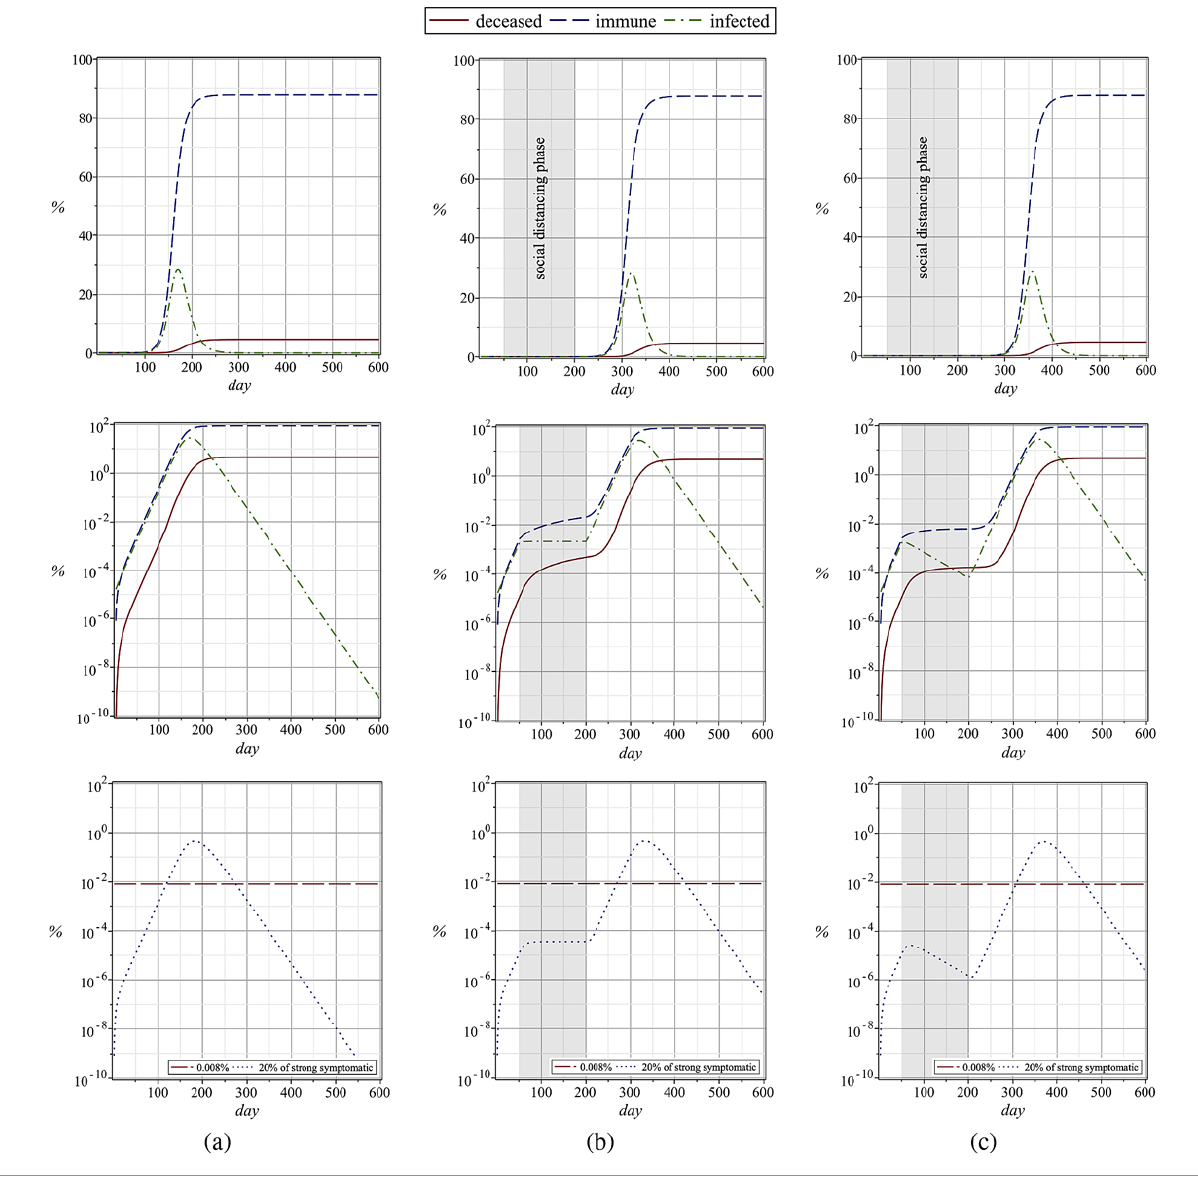
Figure 6: Social distancing from day 50 to day 200. (a) base case; (b) with a 58% lower infection rate (corresponding to a repro- duction number of 1); (c) with a 71% lower infection rate (corresponding to a reproduction number of 0.7). Dashed lines repre- sent the immune ( ), dash-dotted lines the infected ( ) and solid lines the deceased ( ) populations, on the upper panel with linear and in the middle panel with logarithmic scaling. The lower panel logarithmic plot shows 20% of the 𝑖𝑖𝑢𝑢𝑢𝑢𝑢𝑢𝑢𝑢𝑢𝑢 𝑖𝑖𝑢𝑢𝑢𝑢𝑢𝑢 𝑢𝑢𝑢𝑢𝑡𝑡𝑢𝑢 𝑠𝑠0 𝑛𝑛 − 𝑛𝑛 𝑠𝑠 𝑛𝑛 + 𝑛𝑛 𝑛𝑛 strongly symptomatic population (dotted lines) together with the intensive care unit capacity of 0.008% (horizontal long dashed lines). The values are in % of the initial susceptible population size and are plotted over number of days. The grey shading marks the “social distancing”